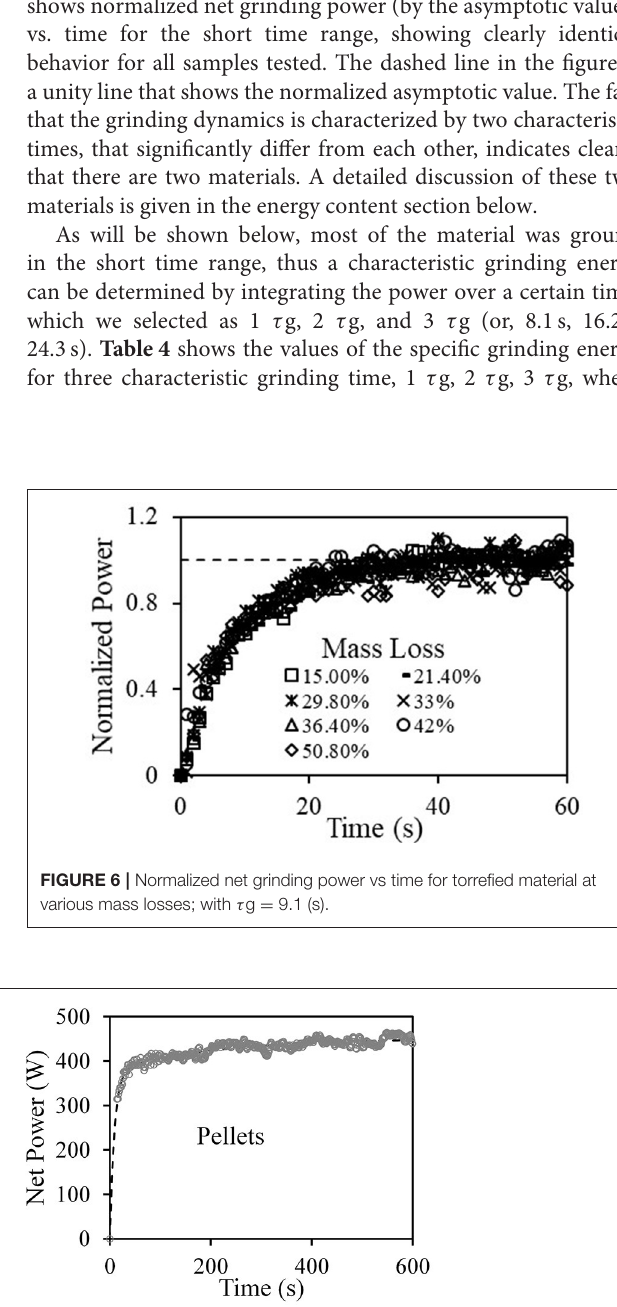
Frontiers in Energy Research |